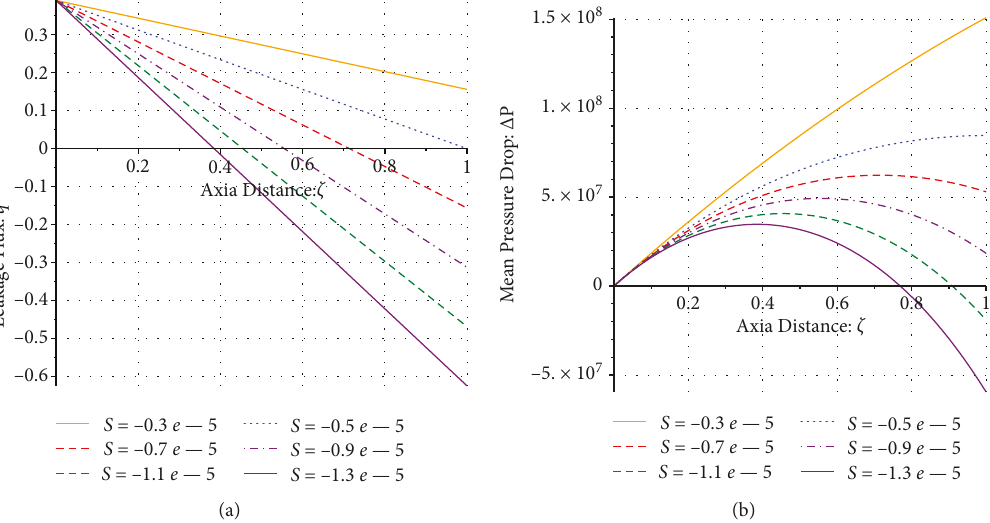
Figure 5: (a) Leakage flux against ζ and (b) mean pressure drop in axial direction against ζ for different values of linear absorption parameter S